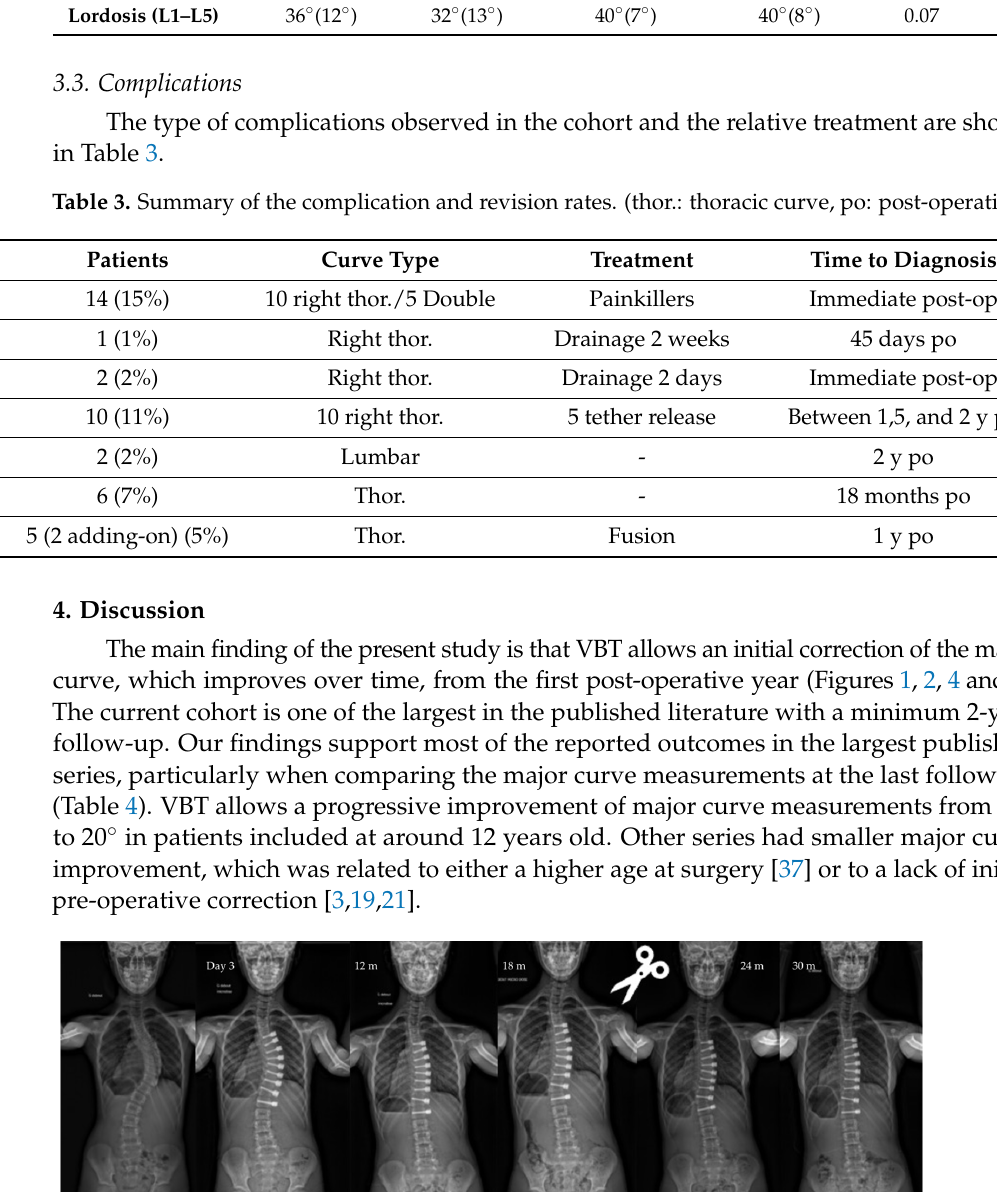
Table 4. Comparison of the main published series on VBT in AIS. (OC: overcorrection; PTX: pneu- mothorax).